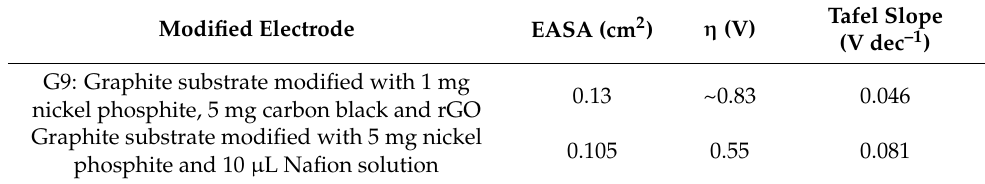
Table 2. The values of some electrochemical parameters for the two modified electrodes. Modified Electrode G9: Graphite substrate modified with 1 mg nickel phosphite, 5 mg carbon black and rGO Graphite substrate modified with 5 mg nickel phosphite and 10 µ L Nafion